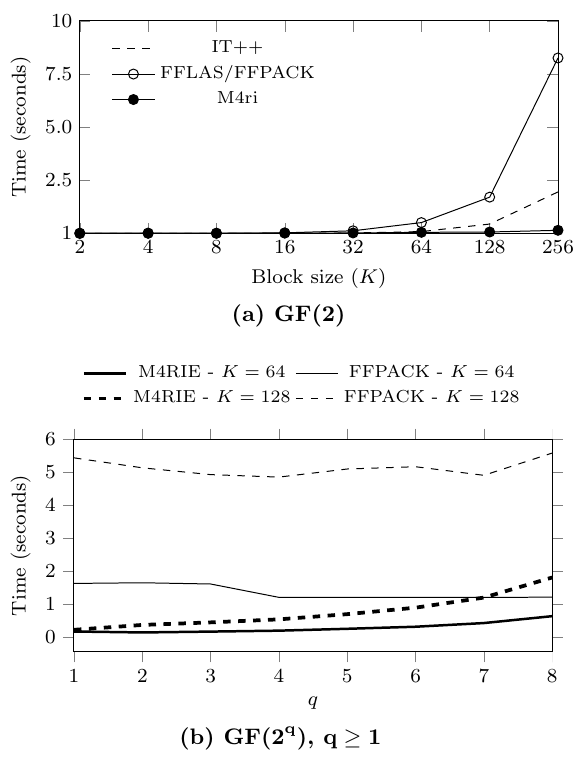
Figure 6: Required time for the rank matrix calcu- lation